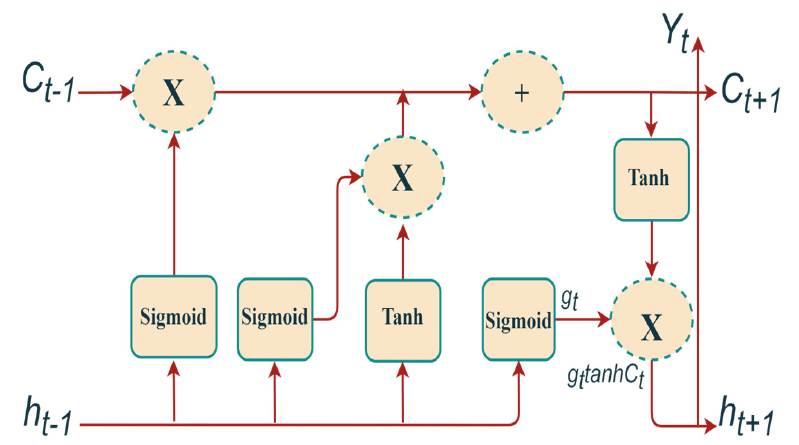
Figure 4. Structure of LSTM model.